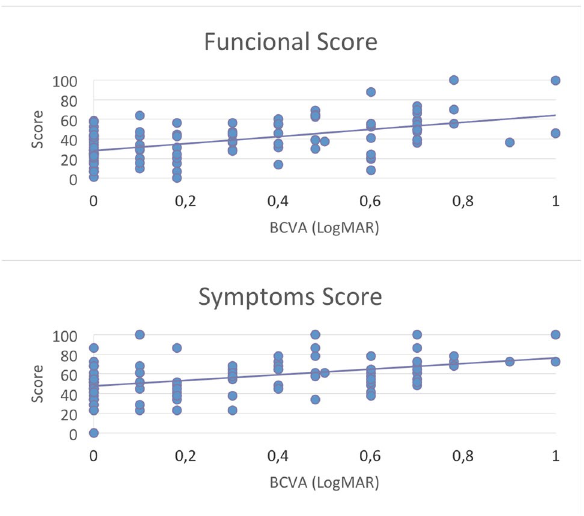
Figure 2. Spearman correlation test showed a positive correlation between visual acuity in LogMAR and both functional (r = 0.4934, p < 0.001) and symptoms (r = 0.4457, p < 0.0001)